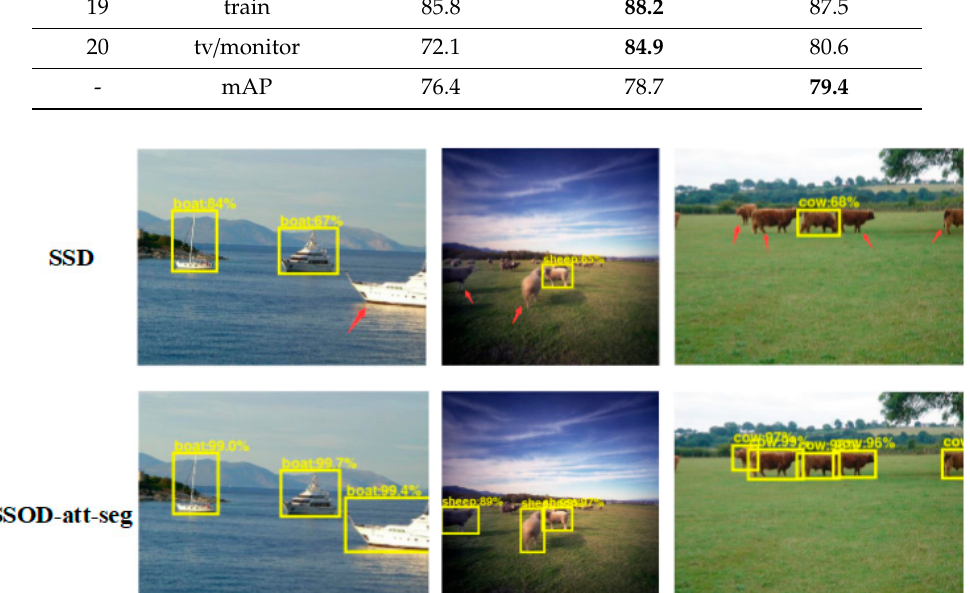
Figure 5. Comparison of detection effects between the SSOD-att-seg algorithm and SSD algorithm. The arrows indicate the objects detected by the SSOD-att-seg algorithm but missed by the SSD algorithm.